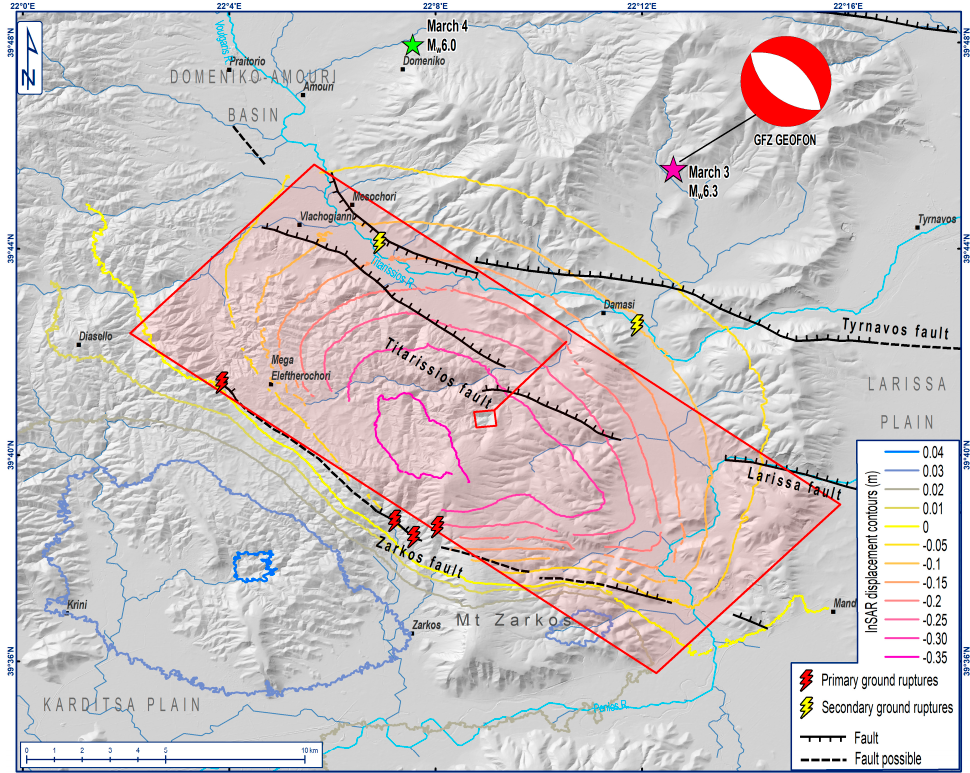
Figure 14. Map of the earthquake effects of the first strong shock (March 3): coseismic ruptures and InSAR displacement contours of Figure 13 [60]. The neotectonic/active faults, the March 3 (M w 6.3) seismic source (red rectangular, after Chatzipetros et al. [60]) with its corresponding moment tensor solution (GFZ GEOFON [66]), and the epicentres of the strongest shocks (March 3 and 4; IG-NOA [58]) are also